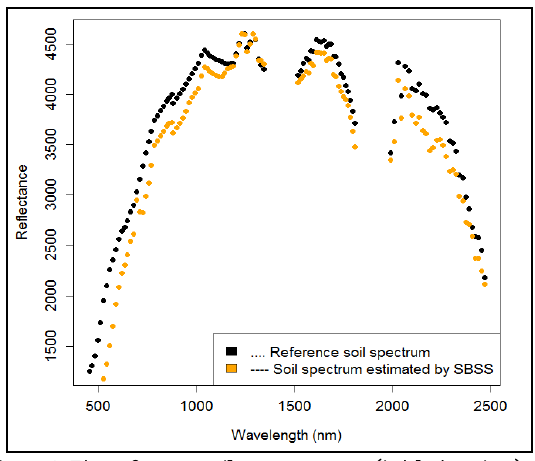
Figure 4: The reference soil spectrum (in black points) and a soil spectrum estimated by SBSS method (brown points) 4.3 Estimation of clay content by PLSR, using soil